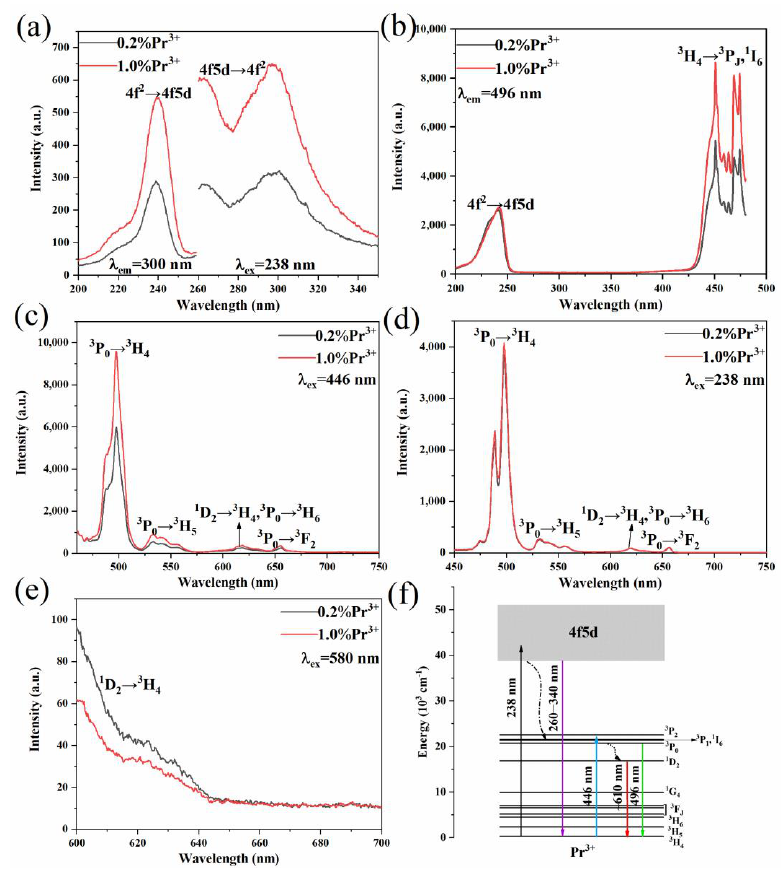
Figure 4. Basic PL properties of Y 7 O 6 F 9 :xPr 3+ (x = 0.2%, 1.0%) phosphors. ( a ) Excitation ( λ em = 300 nm) and emission ( λ ex = 238 nm) spectra. ( b ) Excitation spectra ( λ em = 496 nm). ( c ) Emission spectra (λ ex = 446 nm). ( d ) E mission spectra (λ ex = 238 nm). ( e ) E mission spectra (λ ex = 580 nm). ( f ) Energy level diagram of Pr 3+ . Solid lines represent absorption and emission, and dashed black lines repre- sent nonradiative relaxation.